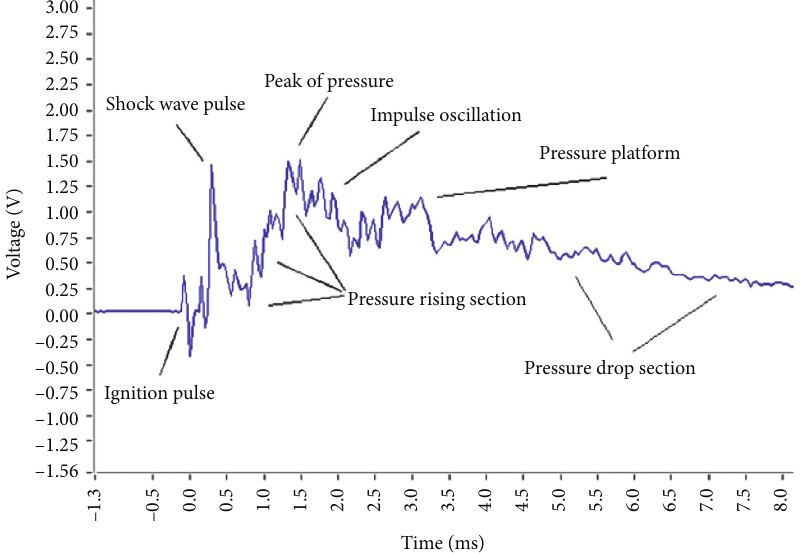
Figure 13: The raw signal recorded by the